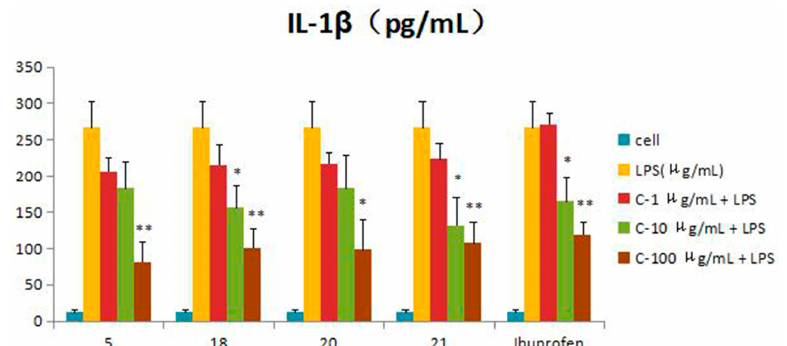
Figure 5. Inhibitory effects of Compounds 5 , 18 , 20 and 21 (1, 10, 100 μ g/mL) on IL-1 β production stimulated by LPS (10 μ g/mL) in RAW 264.7 cells (mouse leukemic monocyte macrophage cell line). Data are expressed as the mean ± S.E.M. of three independent experiments. Cell: cultures were not exposed to lipopolysaccharide (LPS); LPS: cultures were subjected to LPS; LPS + Drug: compounds were added to the cultures during LPS; Positive control: LPS + Ibuprofen. ∗ p < 0.05 vs. LPS; ∗∗ p < 0.01 vs. LPS.